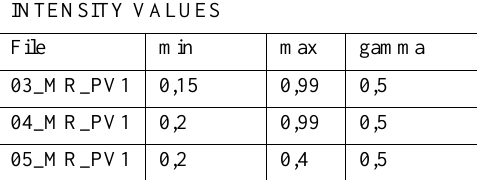
INTENSITY VALUES